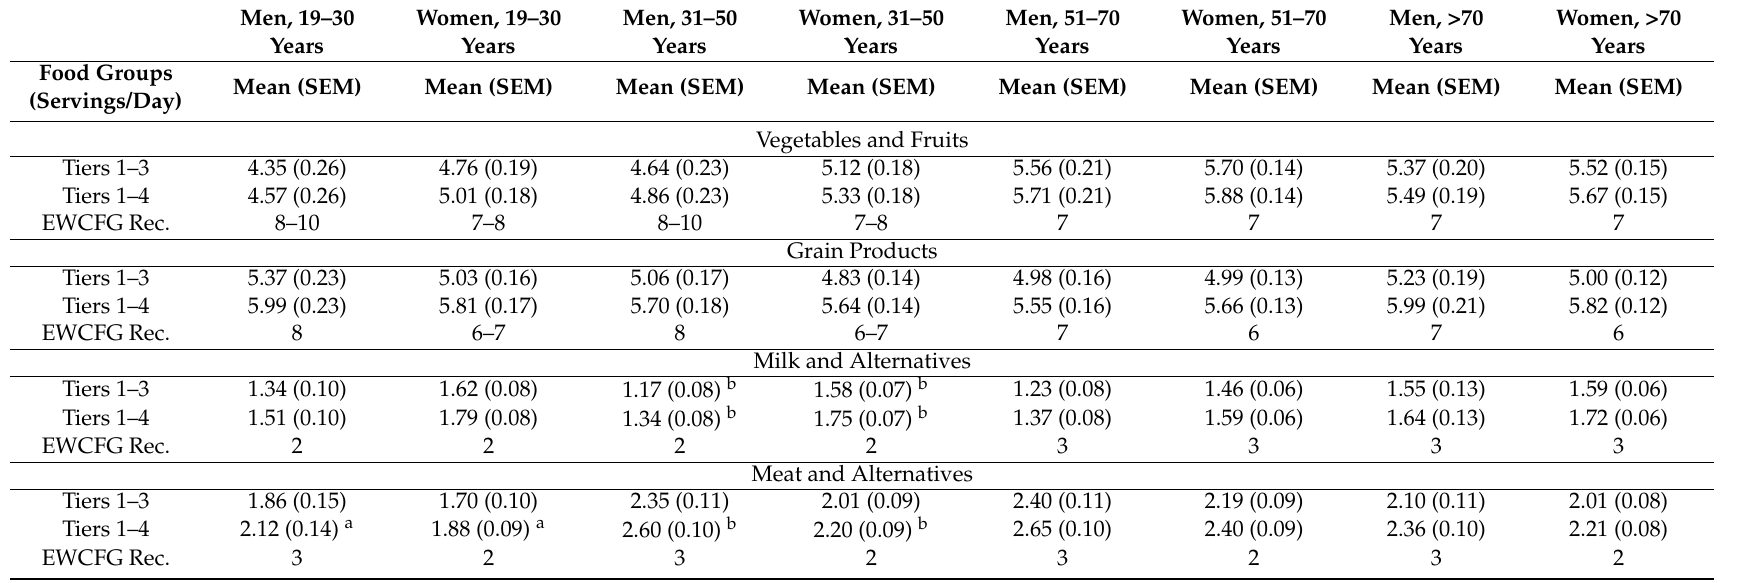
Table 1. Weighted analysis of number of servings from Health Canada’s Eating Well with Canada’s Food Guide (EWCFG) [10] presented based on the 2014 Health Canada’s Surveillance Tool (HCST) Tier system [9] among Canadians ě 19 years * ,†